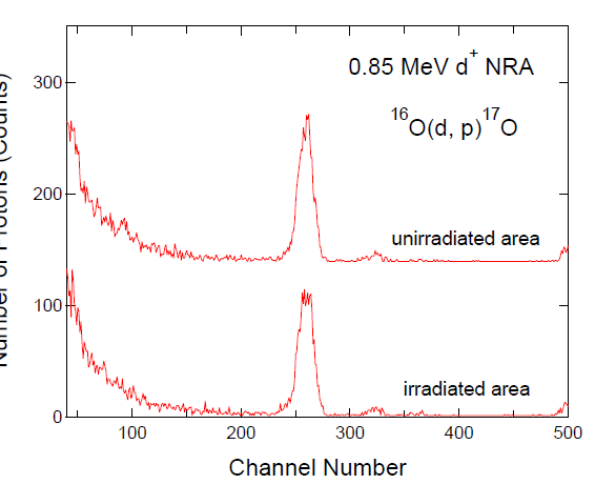
Figure 4. Nuclear reaction analysis (NRA) spectra of the unirradiated and irradiated areas in the sample irradiated with 5 keV-Ar+ ions to a fluence of 1 × 10 15 cm − 2